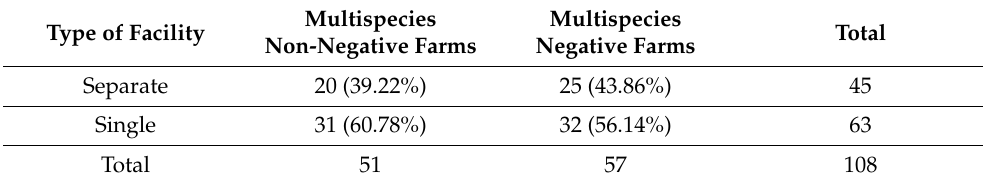
Table 6. Risk factor 2: Results of the association between type of facility adopted and type of farm.